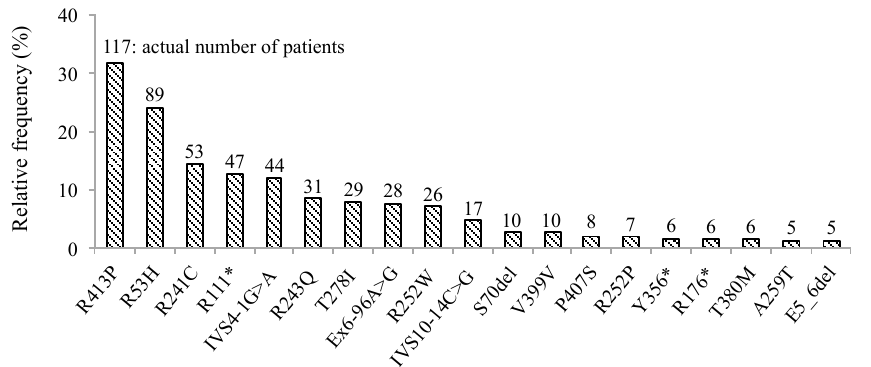
Figure 1. Frequency of PAH variants in 370 patients with elevated Phe levels detected by mass screening. Percentage of patients with mutations in PAH was detected by direct sequencing or multiplex ligation-dependent probe amplification (MLPA) in all the participants enrolled in this study. Numbers at the top of the vertical bars represent the actual number of patients with each mutation. Infrequent mutations have been omitted. Phe; phenylalanine, PAH ; gene encoding phenylalanine hydroxylase, * stop codon.